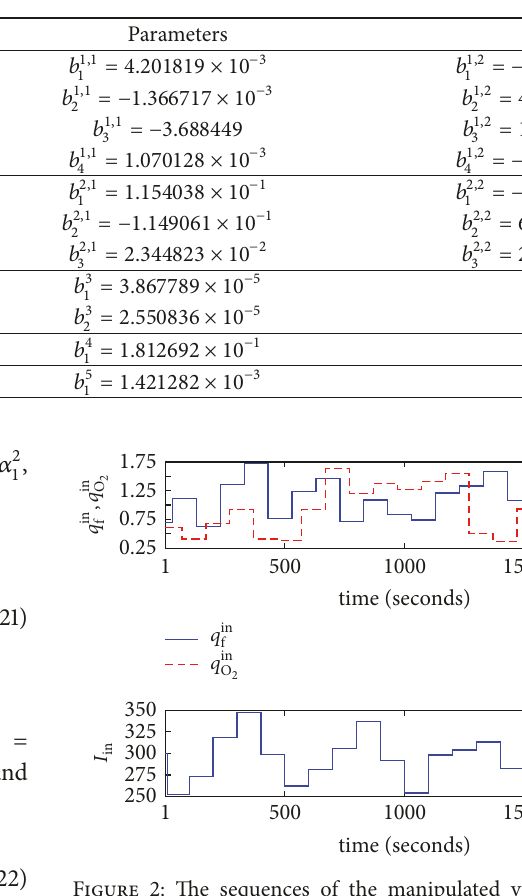
Table 3: Parameters of the full-order discrete-time fundamental model.